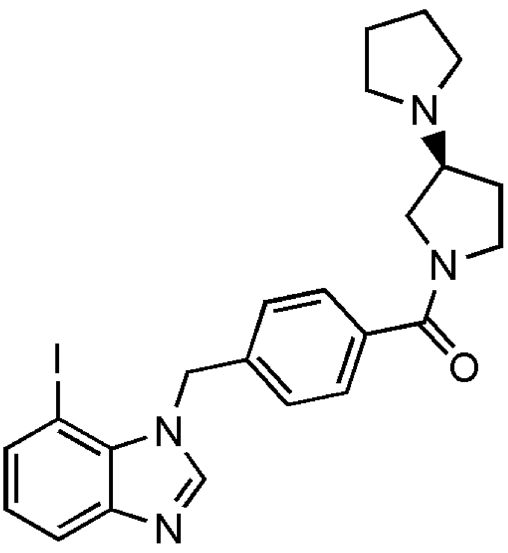
Fig. 1. Chemical Structure of